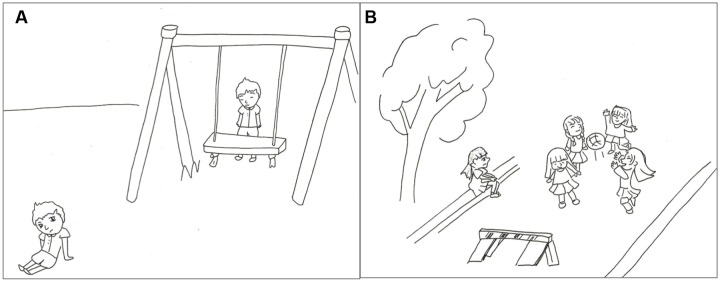
Example of the drawings used for (A) the Social Interpretation and (B) the Moral Judgment tasks (adapted from McGlothlin et al., 2005, and Guerrero et al., in press). The gender and ethnicity of characters depicted matched those of the participants.